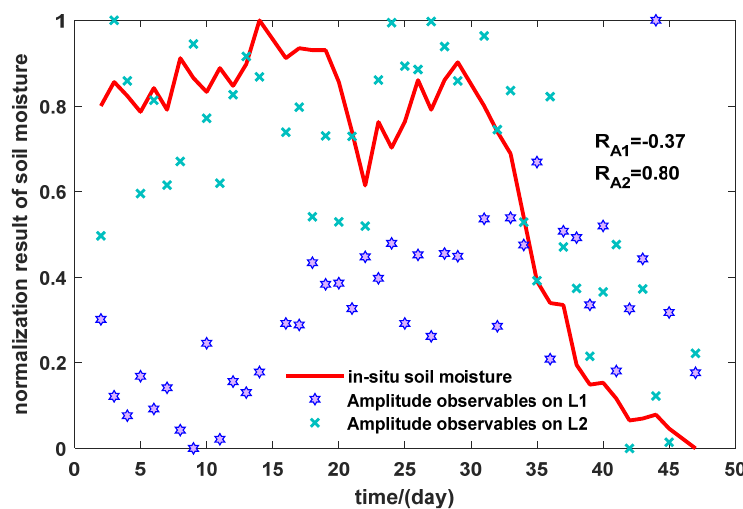
Figure 4. Normalization of in situ soil moisture and observables (amplitude of PRN1).